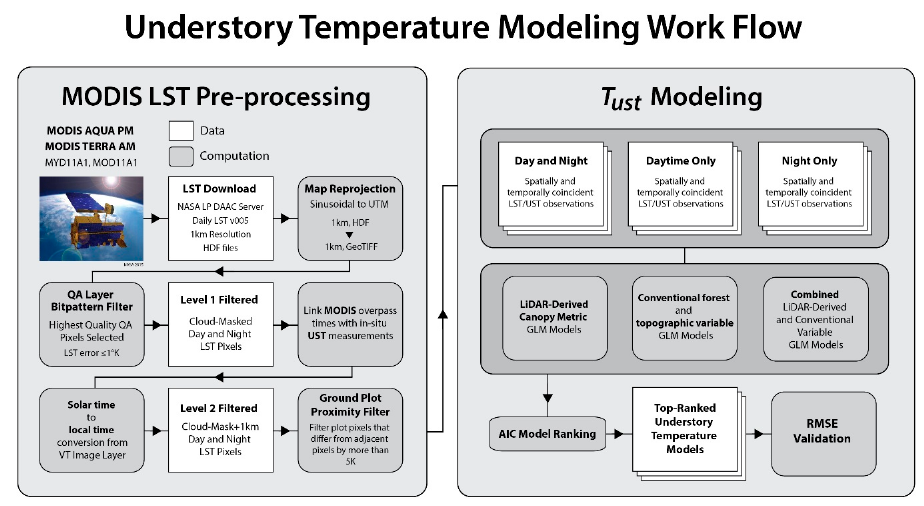
Figure 3. Simplified flow chart of the understory temperature modeling process.